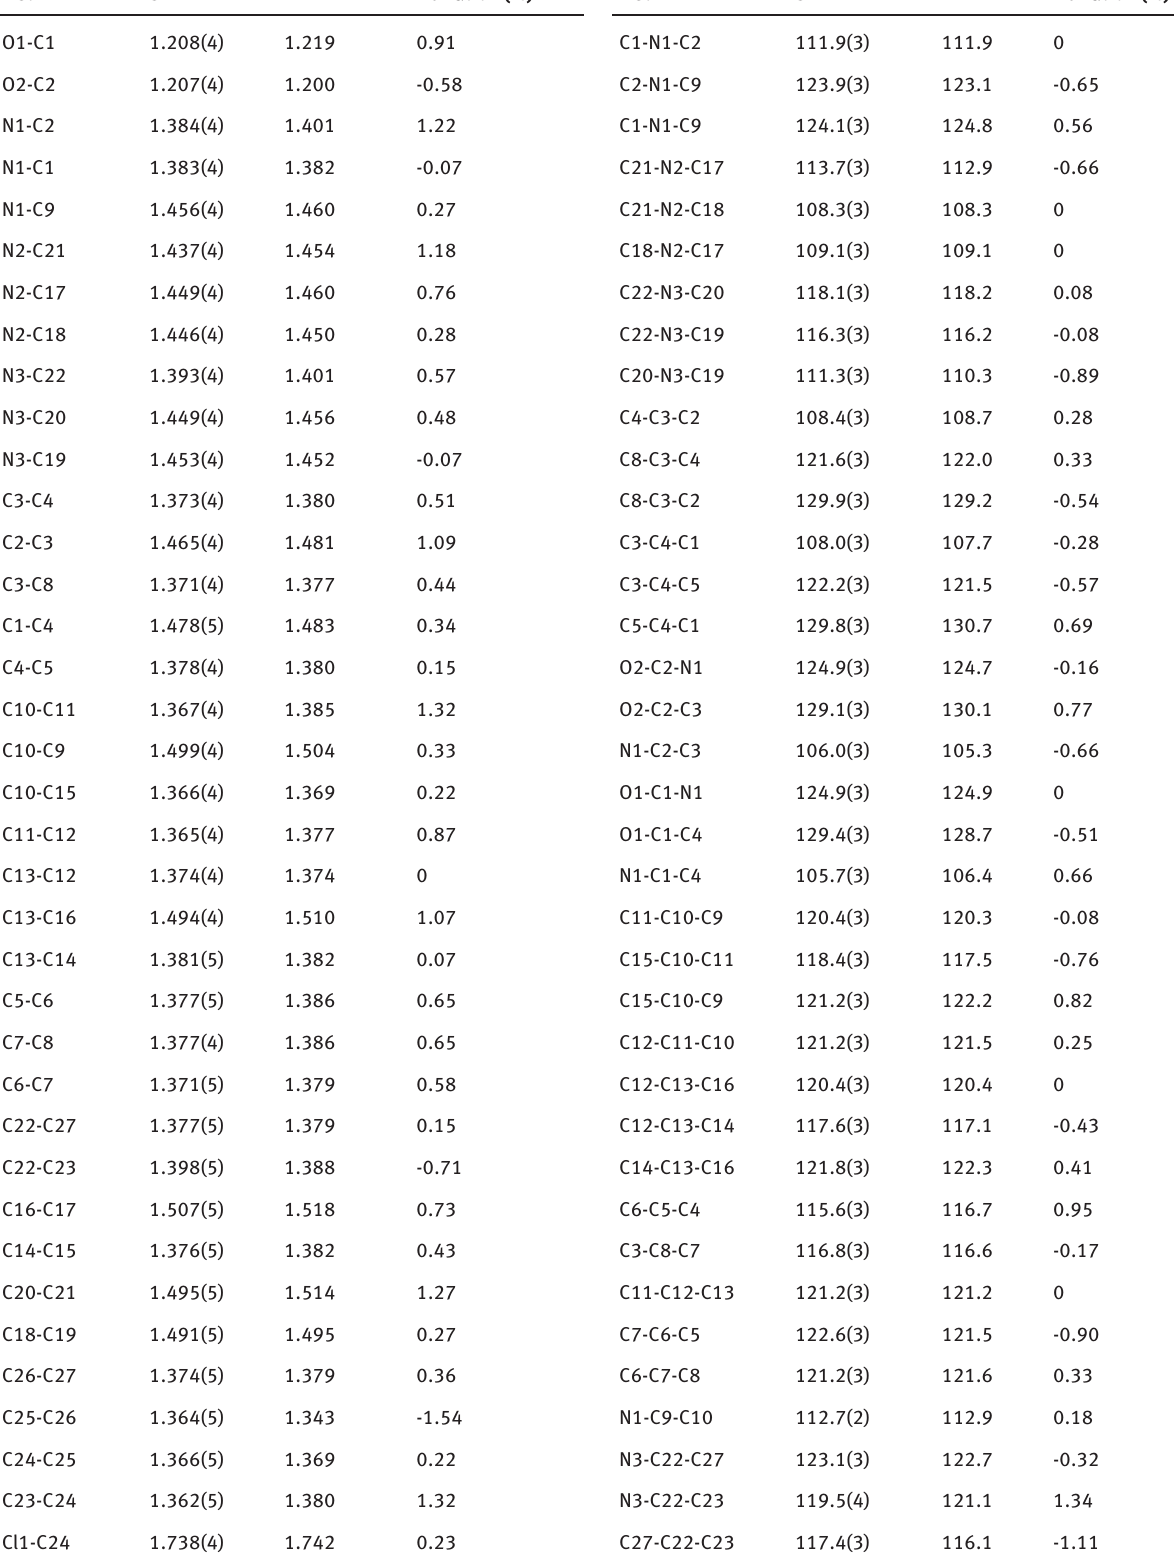
Table 2 : Bond lengths (Å) for based on both single-crystal X-ray diffraction (SXRD) and powder X-ray diffraction (PXRD).